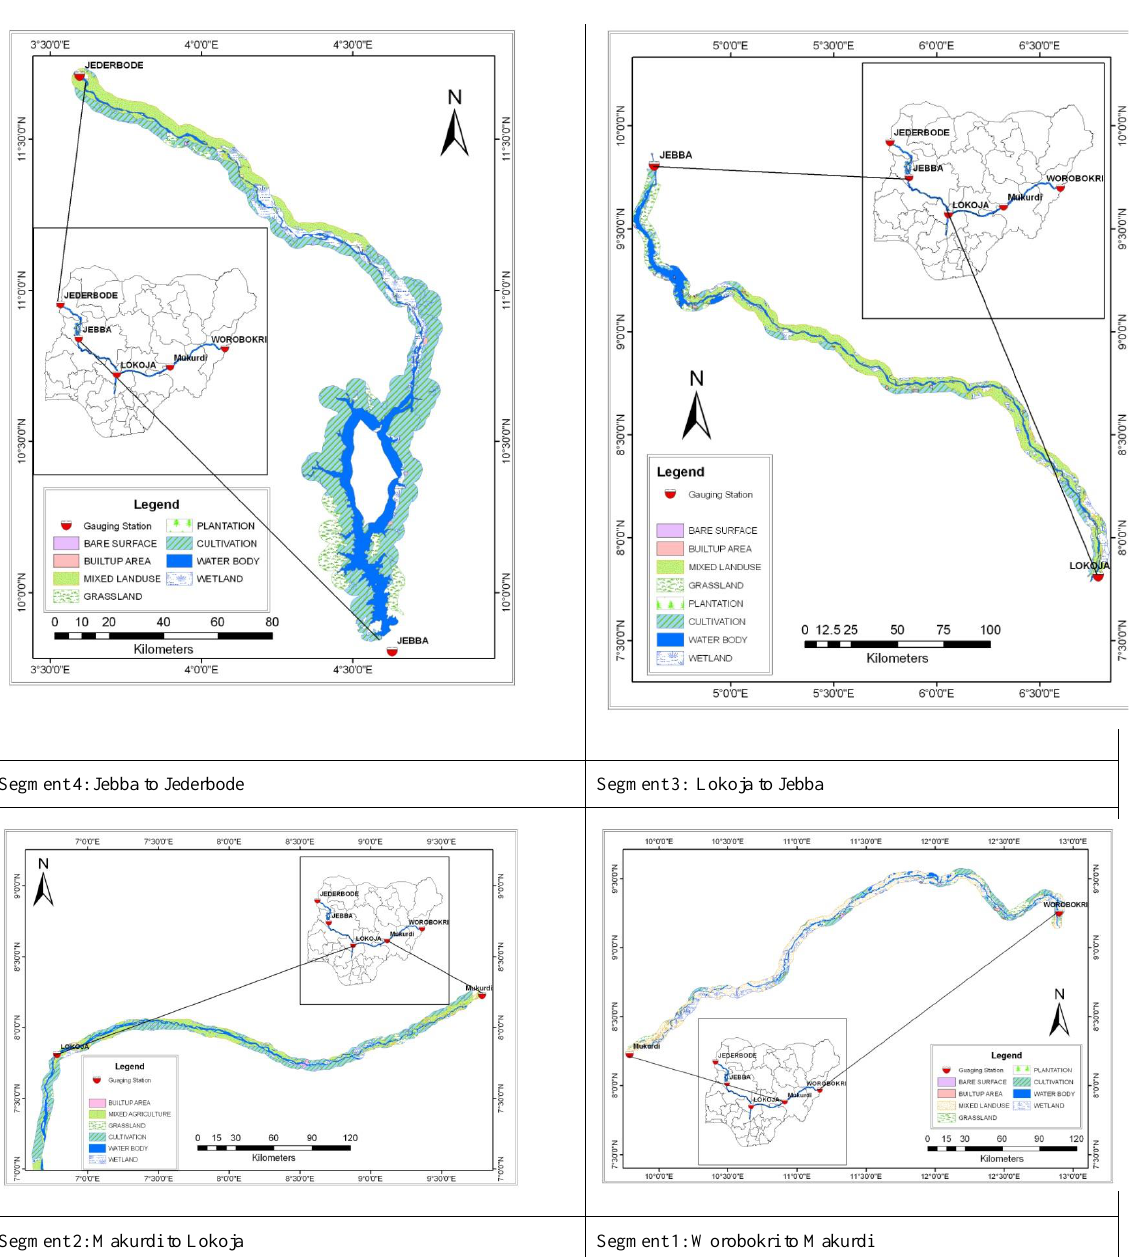
Figure 2: Land use distribution along the Niger-Benue floodplain Figure 2. Land use distribution along the Niger–Benue floodplain. Table 1. FPVI Scores for Land use, Peak Flow and FPVI index Range for vulnerability